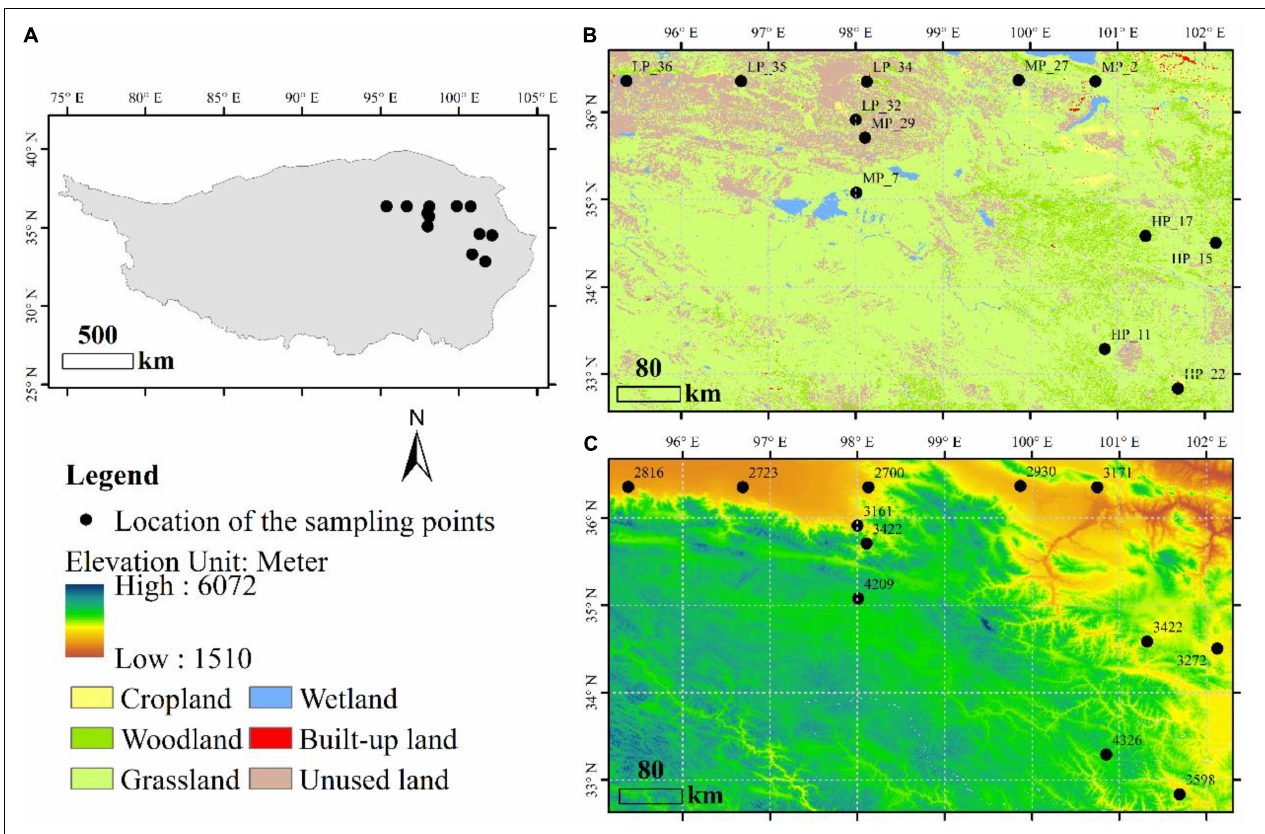
FIGURE 1 | Distribution and description of sample sites, including geographical location (A) , land use type (B) and altitude (C)